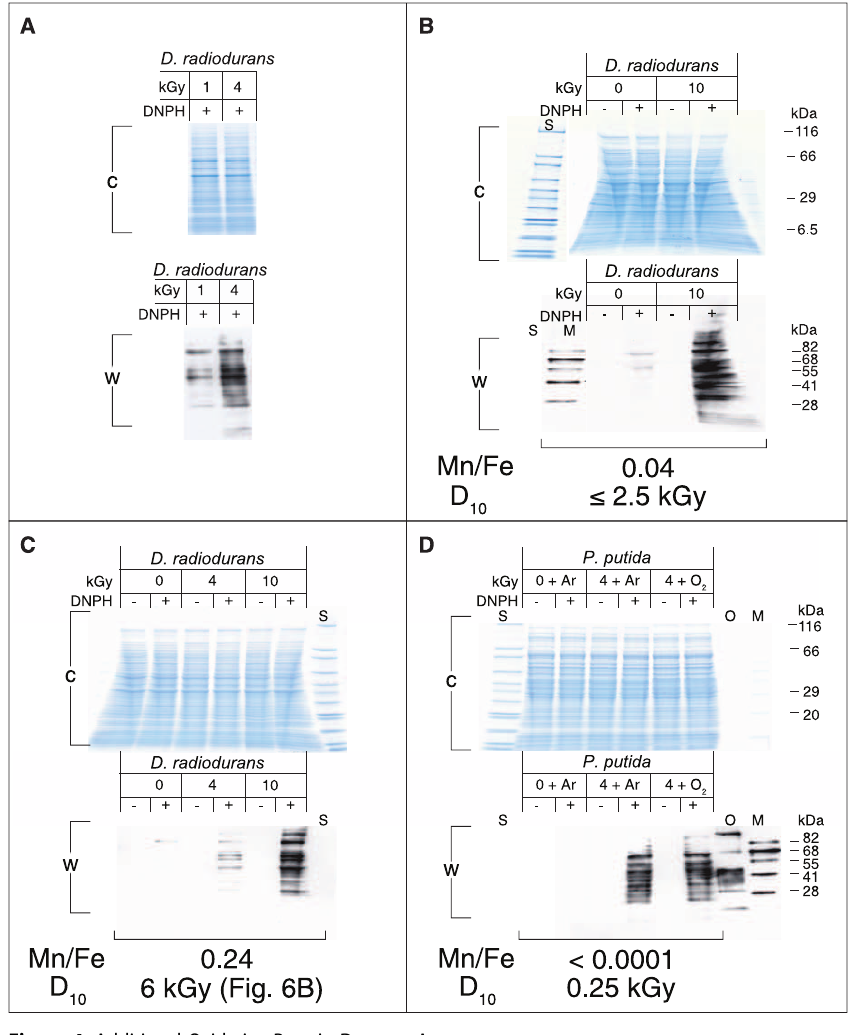
Figure 4. Additional Oxidative Protein Damage Assays (A) In vitro IR-induced oxidative protein damage. Western blot (W) immunoassay of protein-bound carbonyl groups in D. radiodurans (non-irradiated) cell extract adjusted to 500 l M FeCl 2 and irradiated to the indicated doses. A total of 20 l g of protein extract loaded per lane. (B) Mn-depleted, radiosensitive D. radiodurans cells [1] are highly susceptible to oxidative protein damage during irradiation. D. radiodurans was grown in defined rich medium without Mn supplementation (no-Mn DRM) [1] to OD 600 0.8 and exposed aerobically to 10 kGy. A total of 20 l g of protein extract loaded per lane. (C) Decreased survival of D. radiodurans irradiated at pH 10.5 correlates with oxidative protein damage. D. radiodurans was grown to OD 600 approximately 0.9 in TGY (pH 7), adjusted to pH 10.5, and exposed aerobically to the indicated doses. A total of 20 l g of protein extract loaded per lane. (D) P. putida proteins are similarly susceptible to oxidative protein damage when cells are irradiated anaerobically ( þ Ar) or aerobically ( þ O 2 ). P. putida was grown to OD 600 approximately 0.9 in TGY, purged with ultra-high purity Ar, and irradiated in sealed tubes to 4 kGy. Values for intracellular Mn/Fe concentration ratios and D 10 at the bottom of (B), (C), and (D), as reported previously [1]. A total of 20 l g of protein extract loaded per